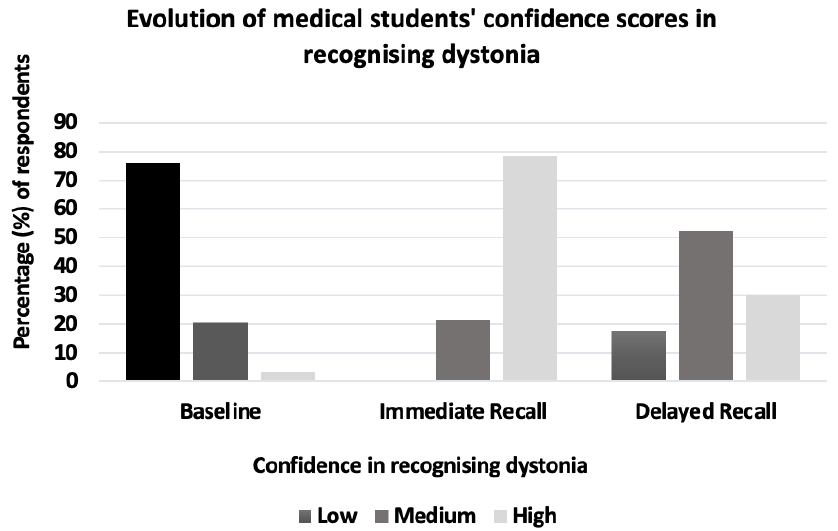
Figure 5. Medical student confidence in recognising dystonia on baseline, immediate- and delayed- recall questionnaire. Prior teaching on dystonia was associated with significantly greater confidence in recognising it in a patient ( p < 0.001), as was seeing a patient with dystonia or observing it being included in a differential diagnosis ( p < 0.001).